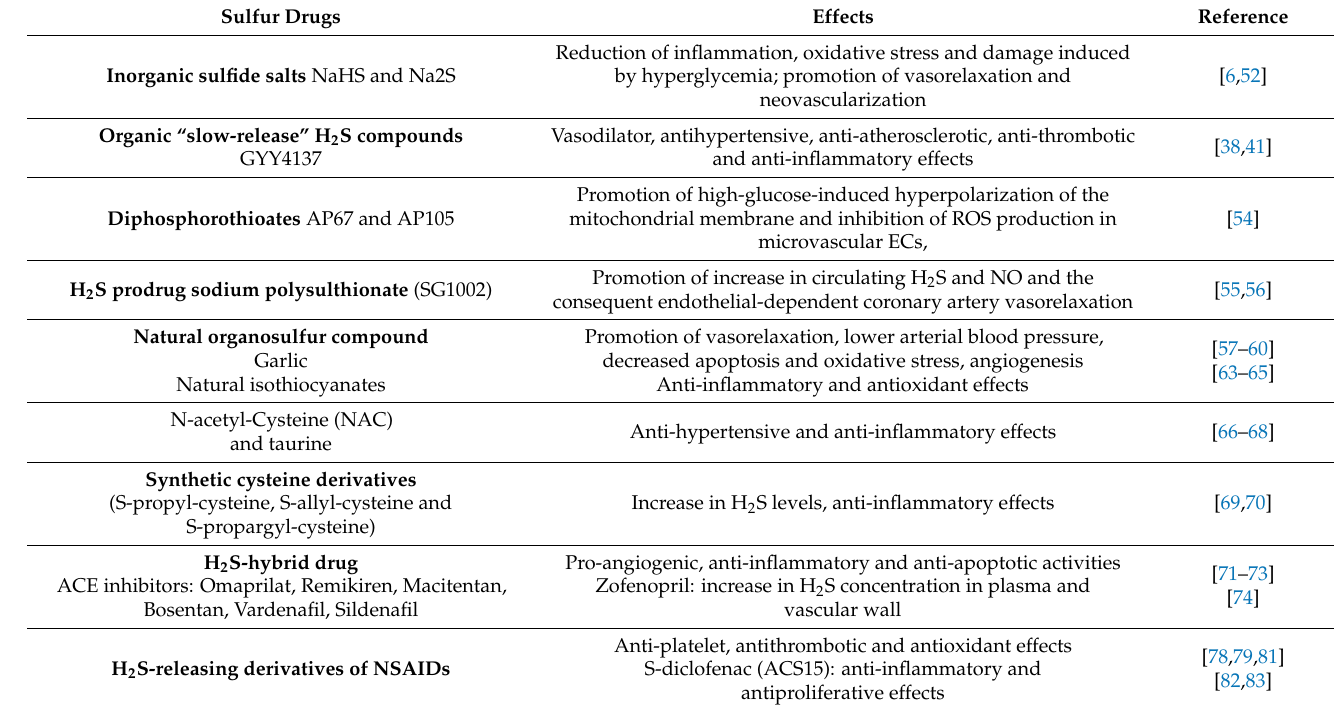
Table 1. Summary of the main biological effects of sulfur